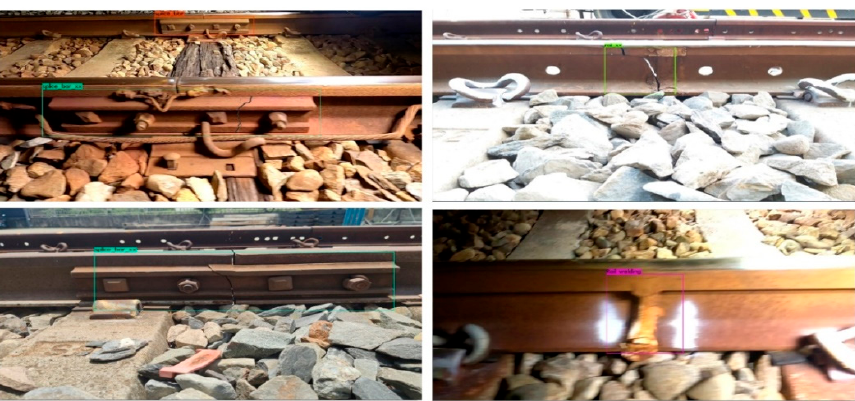
Figure 12. Some examples of detected defective track components in the side view by the trained YOLOv4 ‐ Tiny. Upper left: Fishplate_bar_XX (generated); upper right: Rail_XX (real); lower left: Fishplate_bar XX (real); lower right: Rail_welding_O.